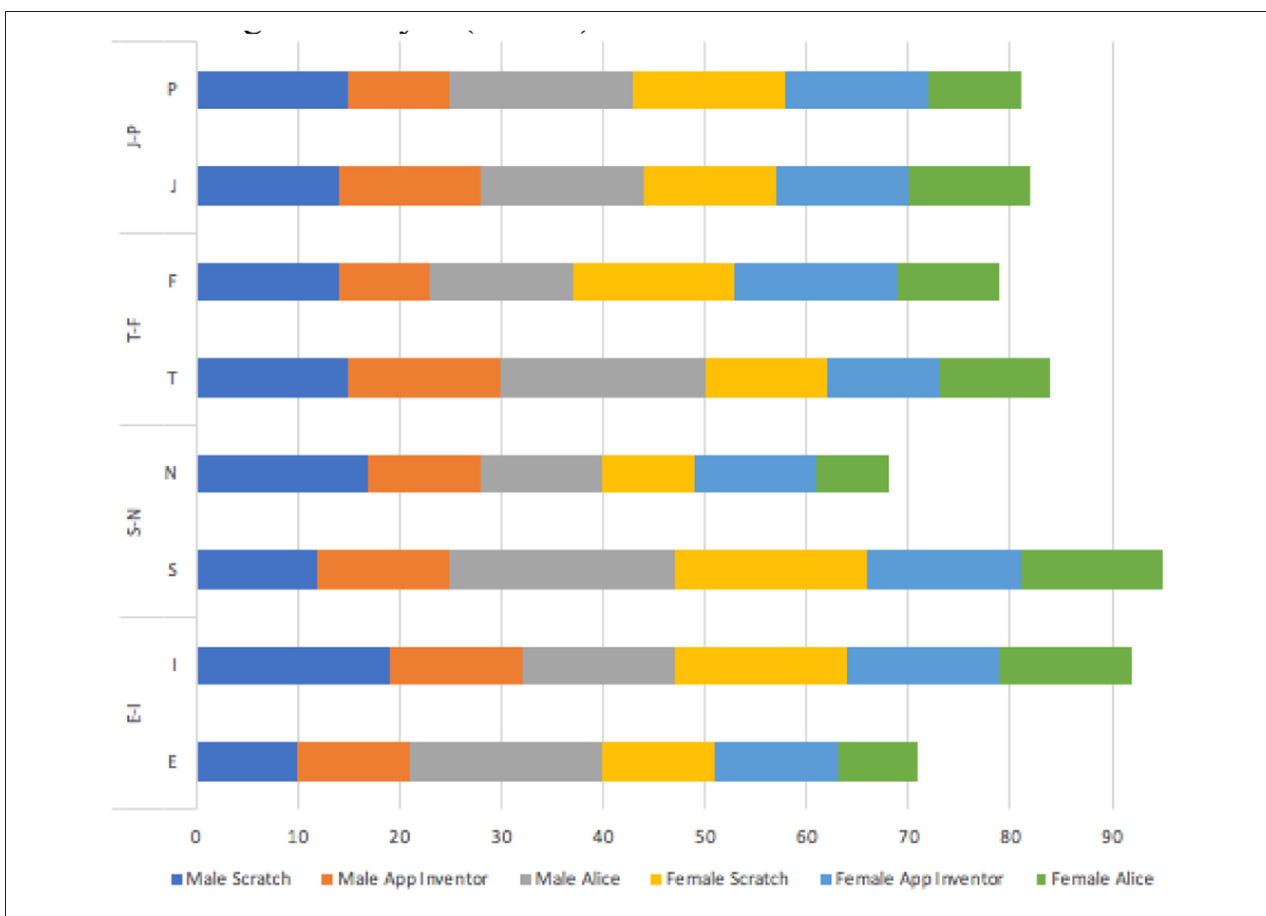
FIGURE 3 | Gender and cognitive styles (MBTI) per